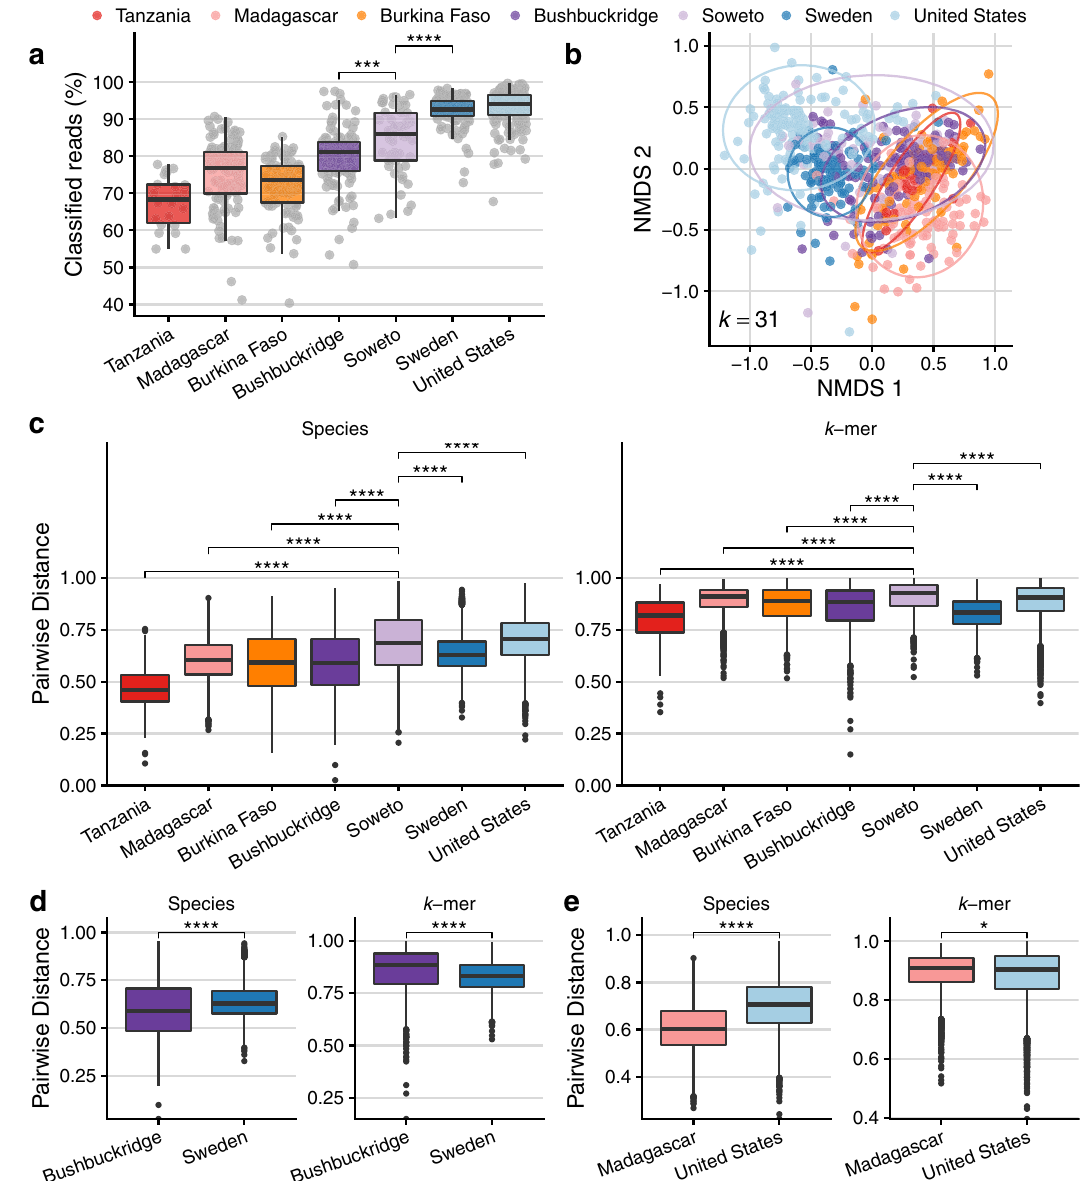
Fig. 4 Comparison of beta diversity between communities calculated by taxonomy vs. nucleotide k -mer composition. a Percentage of reads classi fi able at any taxonomic rank, by cohort, based on a reference database of all genomes “ scaffold ” quality or higher in RefSeq and GenBank as of January 2020. Read classi fi cation is higher in western vs. nonwestern microbiomes (one-sided Wilcoxon rank-sum test between Soweto and Sweden, p = 2.56e − 8), and higher in Soweto relative to Bushbuckridge (one-sided Wilcoxon rank-sum test, p = 2.43e − 4). b Comparison of microbiome sequence data using k -mer sketches, a reference-free approach that allows comparison of nucleotide sequence composition. Brie fl y, a hash function generates signatures at varying sequence lengths ( k ) and k -mer sketches can be compared between samples. Plot shows non-metric multidimensional scaling (NMDS) of angular distance values between each pair of samples at k = 31 (approx. species-level) 61 . c – e Comparison of pairwise beta diversity within communities using Bray – Curtis distance for species and angular distance for nucleotide k -mer sketches. c Species beta diversity is higher in Soweto vs. all populations (one-sided Wilcoxon rank-sum test, FDR-adjusted q < 2.7e − 16 for all tests) except for the United States, where beta diversity in Soweto is lower (one-sided Wilcoxon rank-sum test, q = 4.05e − 6). Nucleotide k -mer diversity is higher in Soweto vs. all populations (one-sided Wilcoxon rank-sum test, FDR-adjusted q < 2.2e − 16 for all tests). d Species beta diversity is higher in Sweden compared to Bushbuckridge, but nucleotide k -mer distance is higher in Bushbuckridge ( p < 2.22e − 16 for both tests). e Species beta diversity is higher in the United States cohort compared to the Malagasy, but nucleotide k -mer distance is higher in the Malagasy ( p < 2.22e − 16 species, p = 0.034 k -mer). For all box plots in a , c – e , lower and upper hinges correspond to the fi rst and third quartiles, upper and lower box plot whiskers represent the highest and lowest values within 1.5 times the interquartile range, and the horizontal line represents the median. Signi fi cance values for two-sided Wilcoxon rank-sum tests denoted as follows: * p < 0.05, ** p < 0.01, *** p < 0.001, **** p < 0.0001. One sample per participant, sample size in a – e is: n = 22 Tanzania, n = 112 Madagascar, n = 90 Burkina Faso, n = 118 Bushbuckridge, n = 51 Soweto, n = 100 Sweden, n = 134 United